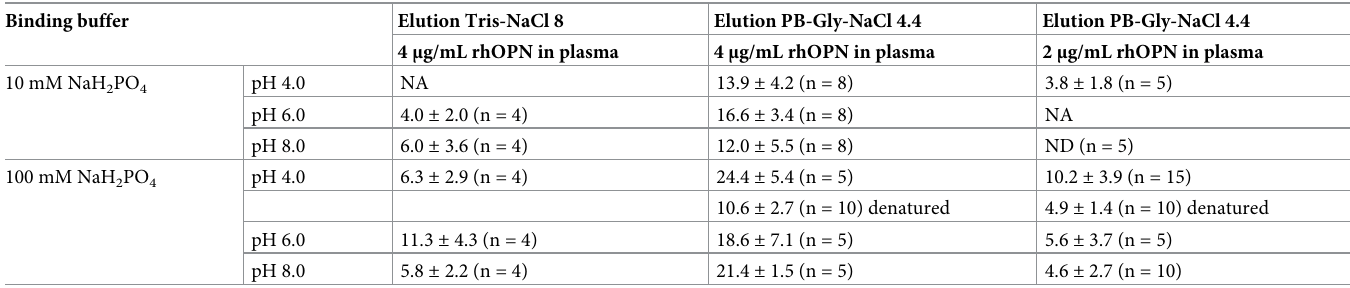
Table 3. MALDI-MS S/N data on peak m/z 1854.898 of trypsin digests of Elution fraction 3, from plasma samples, using different binding and elution buffers. Binding buffer Elution Tris-NaCl